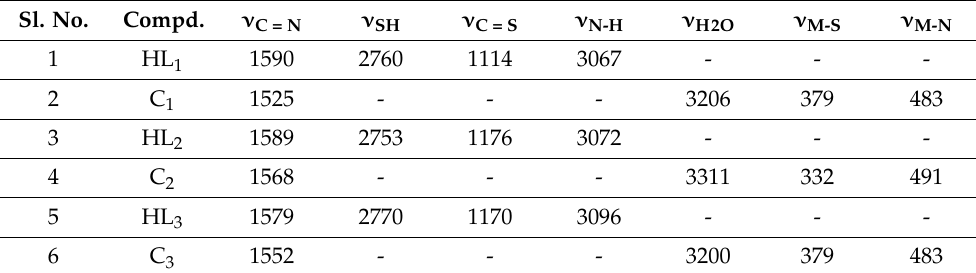
Table 2. FT-IR spectral data of ligands and metal complexes (cm − 1 ). Sl. No.